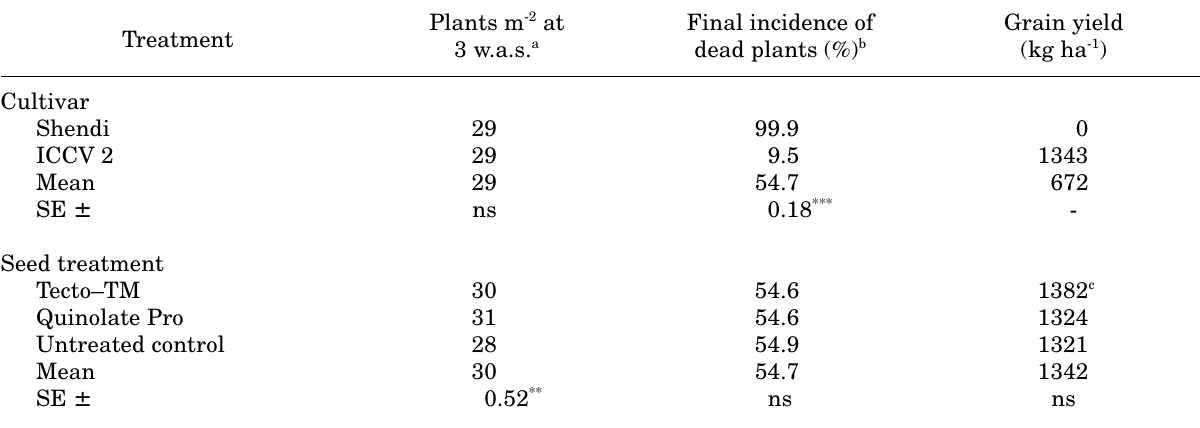
Table 2. Effect of chickpea cultivar and fungicide seed treatment on crop stand, wilt incidence and grain yield in a wilt-infected plot at Hudeiba Research Station, Ed-Damer, Sudan in 1993. Plants m -2